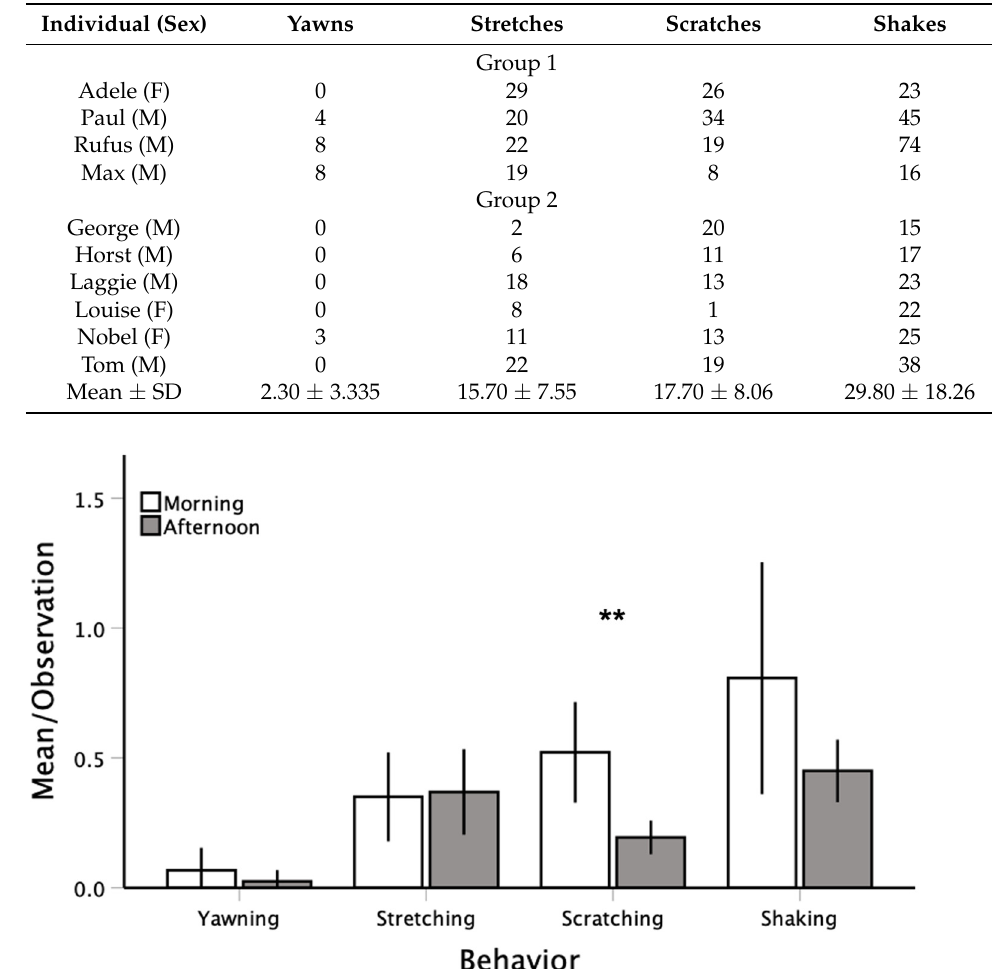
Figure 2. The average behavioral frequency per bird across the morning and afternoon observations. Note: M ± 95% CI; ** p < 0.01.